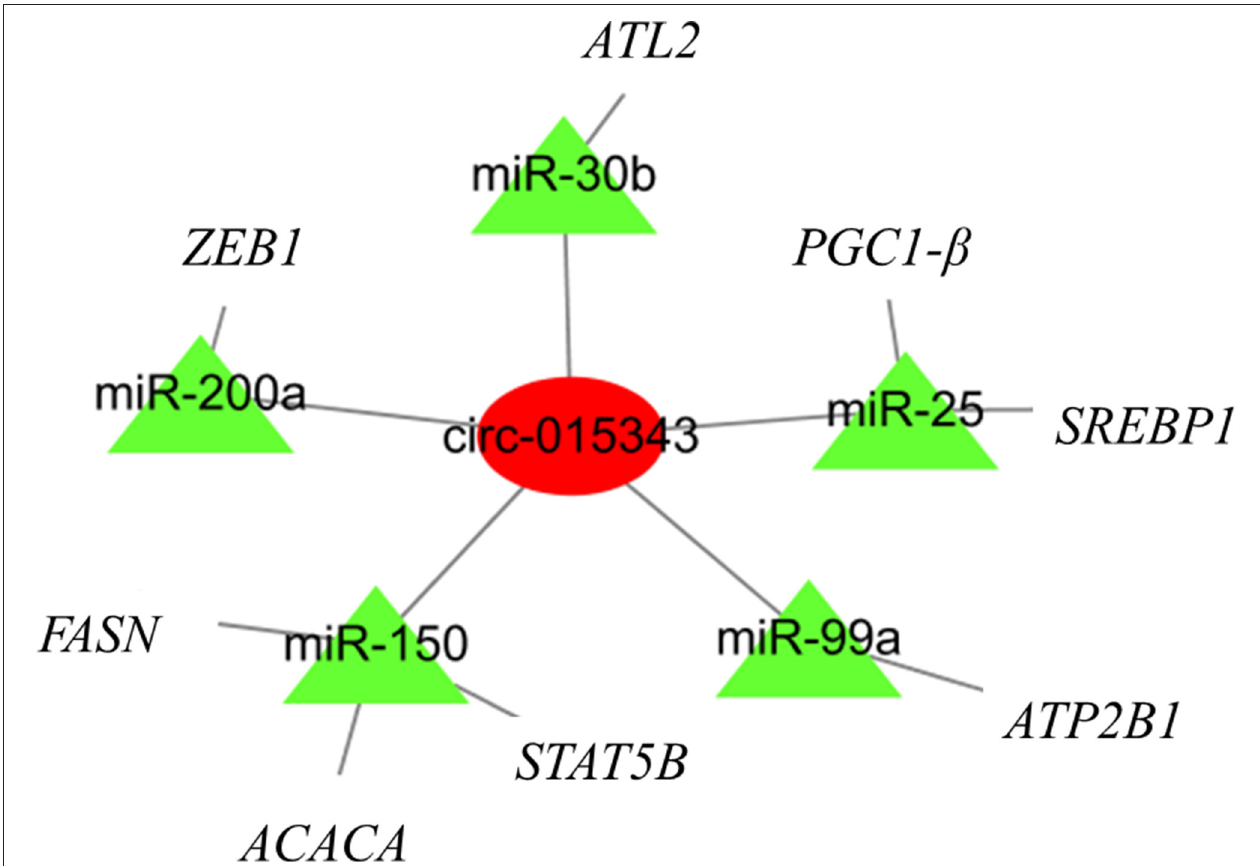
FIGURE 9 | The circRNA-miRNA-mRNA regulatory network. The red circle represents circ_015343, while green triangles indicate predicted miRNAs for